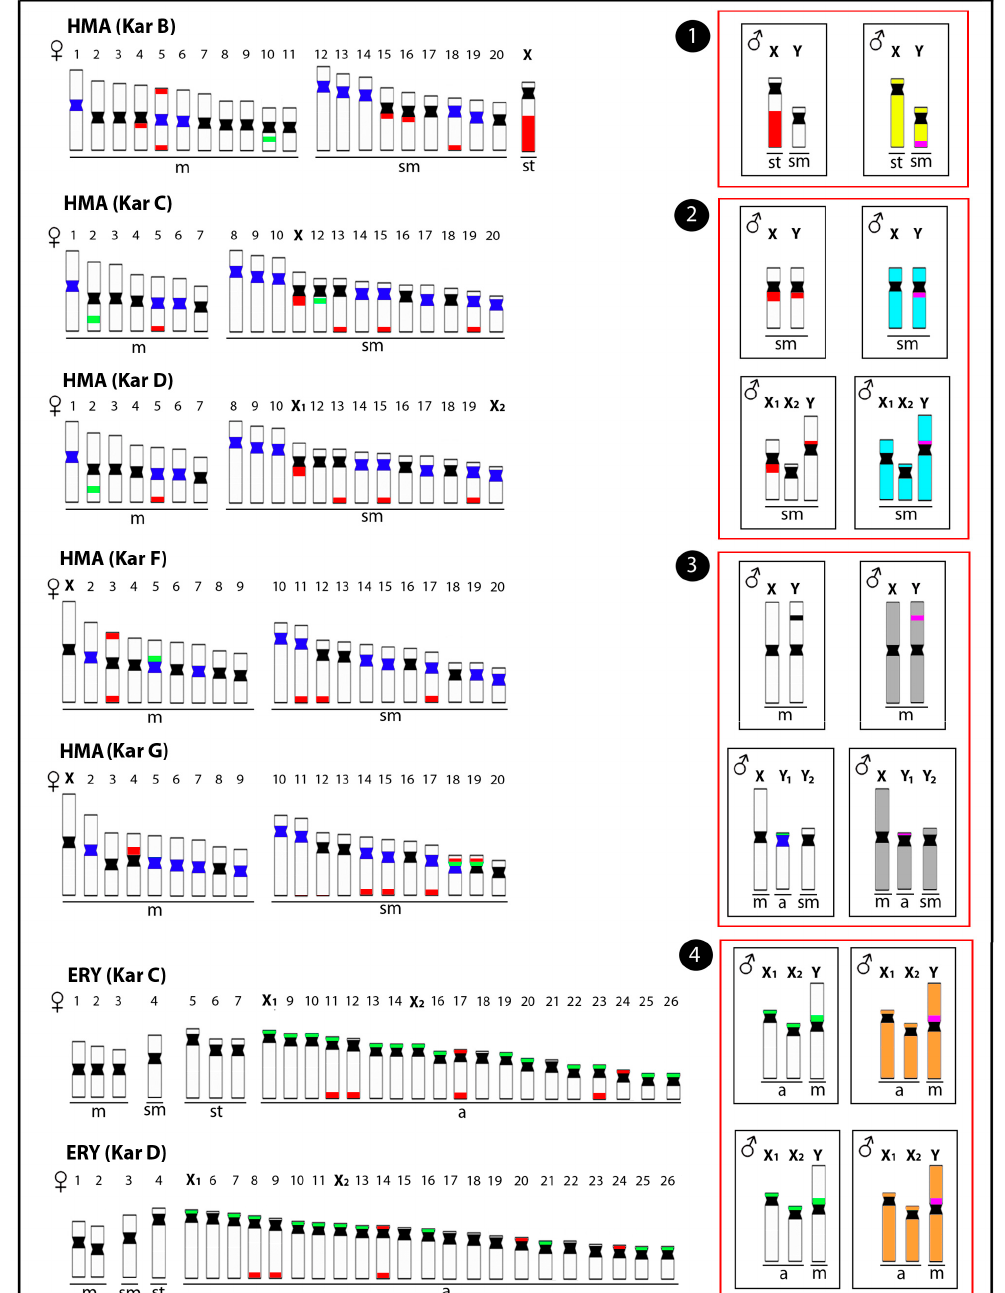
Figure 2. Representative idiograms of Erythrinidae species Hoplias malabaricus (HMA) and Erythrinus erythrinus (ERY) with differentiated sex chromosomes, highlighting the distribution of different classes of repetitive DNAs and the male-specific regions. The locations of the satellite 5SHindIII-DNA, 18S rDNA, and 5S rDNA sites on the chromosomes are indicated in dark blue, red, and green, respectively. The male-specific regions identified by CGH are highlighted in pink. The sex chromosomes of these species have resulted from at least four independent evolutionary events (red boxes), including ( 1 ) the XY chromosomes of HMA karyomorph B (yellow), ( 2 ) the XY chromosomes of HMA karyomorph C and their derived X 1 X 2 Y chromosomes of karyomorph D (light blue), ( 3 ) the XY chromosomes of HMA karyomorph F and the XY 1 Y 2 chromosomes of karyomorph G (grey), and ( 4 ) the X 1 X 2 Y chromosomes of ERY karyomorphs C and D (orange). m = metacentric, sm = submetacentric, st = subtelocentric and a = acrocentric chromosomes. Data from [25,45,50,59,60].